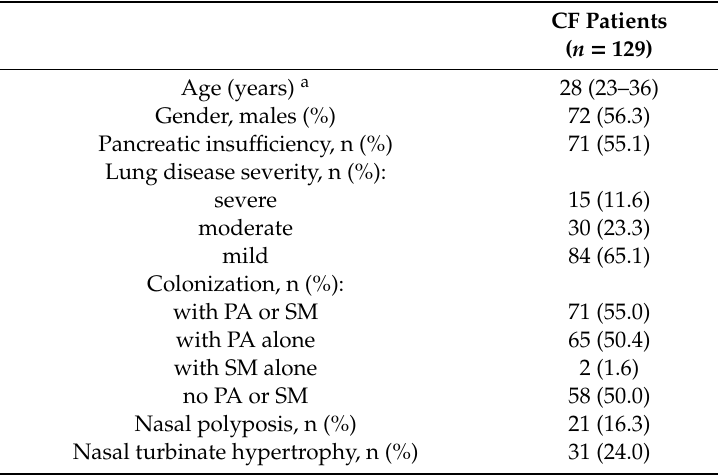
Table 1. Demographic and clinical parameters of adult patients with cystic fibrosis